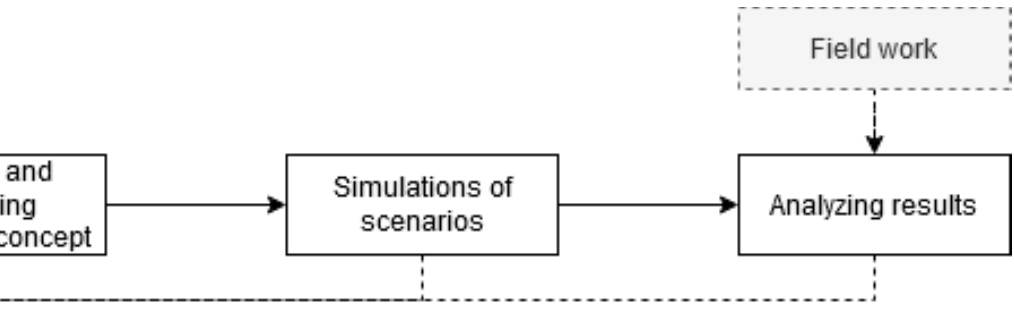
Figure 6. The workflow applied in this